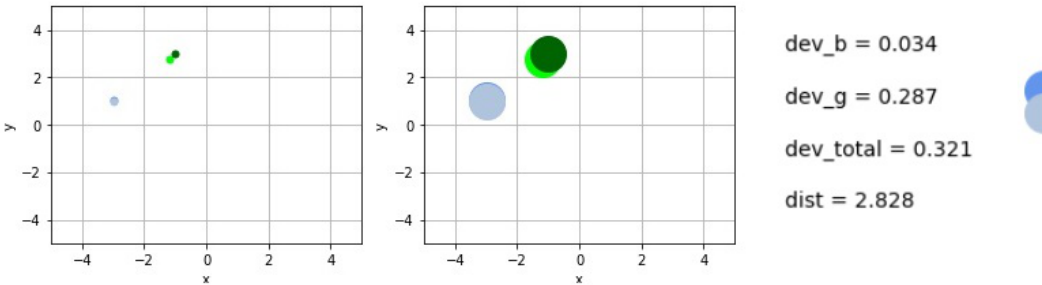
Figure 7. Example for the real and predicted midpoints and